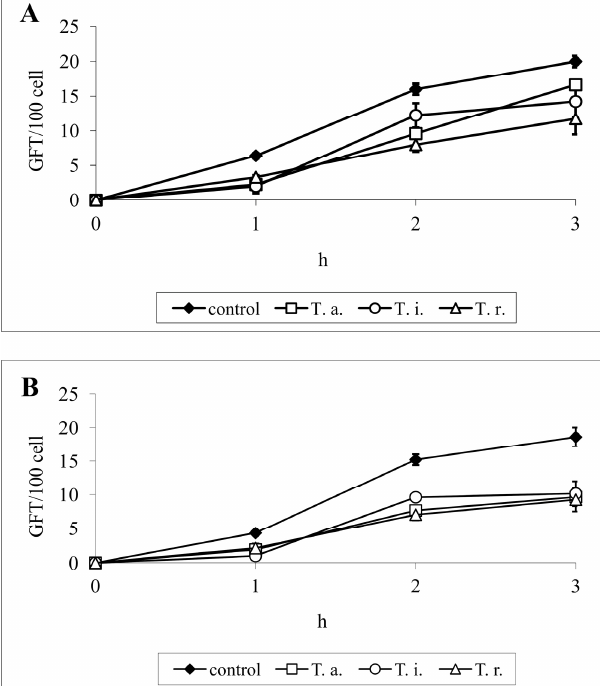
Figure 3. Kinetics of C. albicans ATCC 10231 germ tube formation after 1, 2, 3 h of incubation in RPMI-FCS medium in the presence of T. alexandrinum